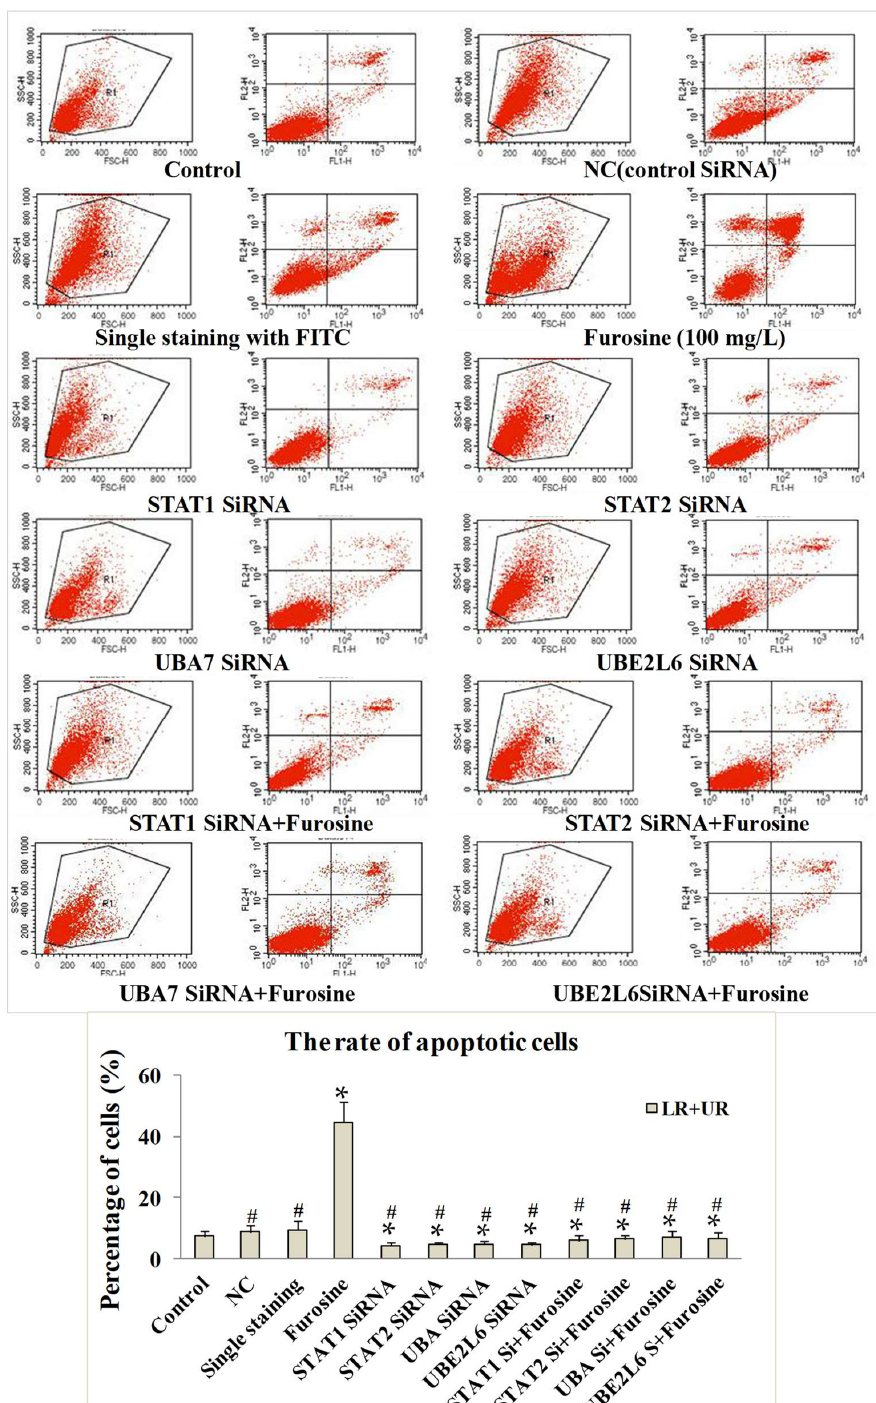
Figure 4. The effect of furosine on cell apoptosis by annexin V/PI staining. Control stood for cells without any treatment; NC stood for cells treated with control SiRNA; single staining group stood for cells stained with annexin-FITC; Si stood for SiRNA of the aimed factor. All the data were represented as mean ± SD, * p < 0.05, compared with the control. # p < 0.05, compared with the furosine treatment group ( n = 3).